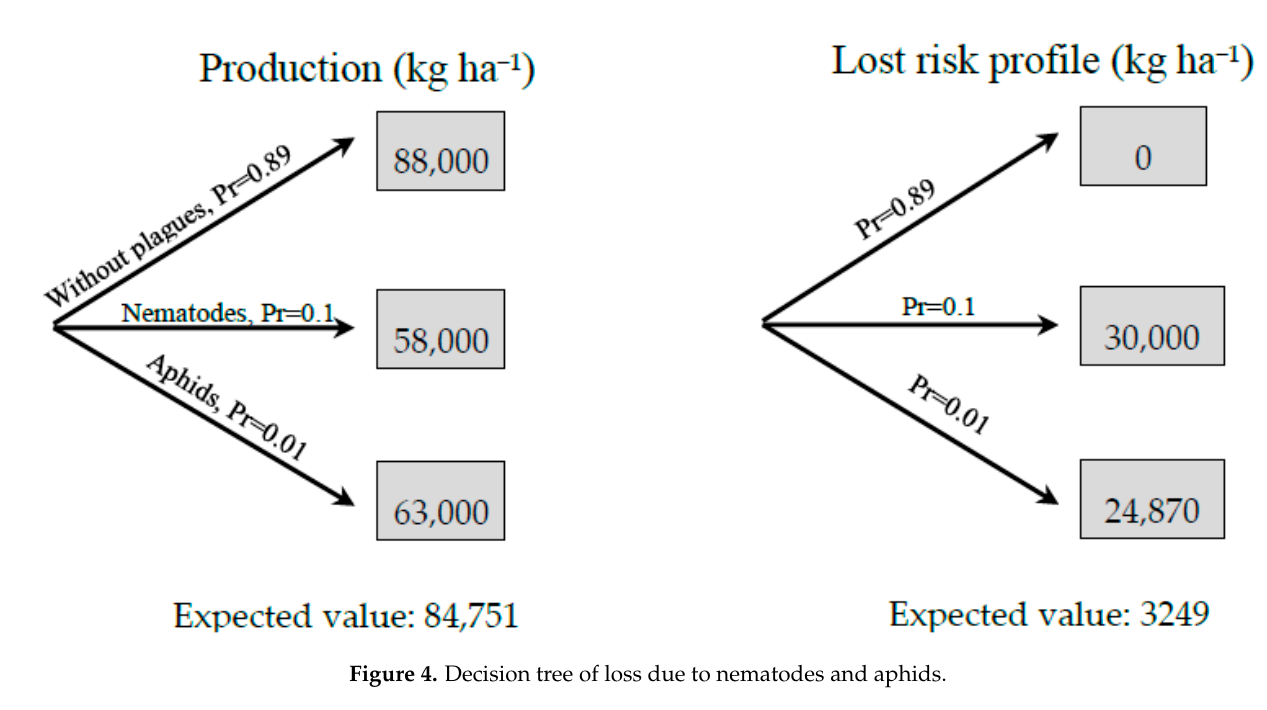
Table 5. Risk due to salinity.